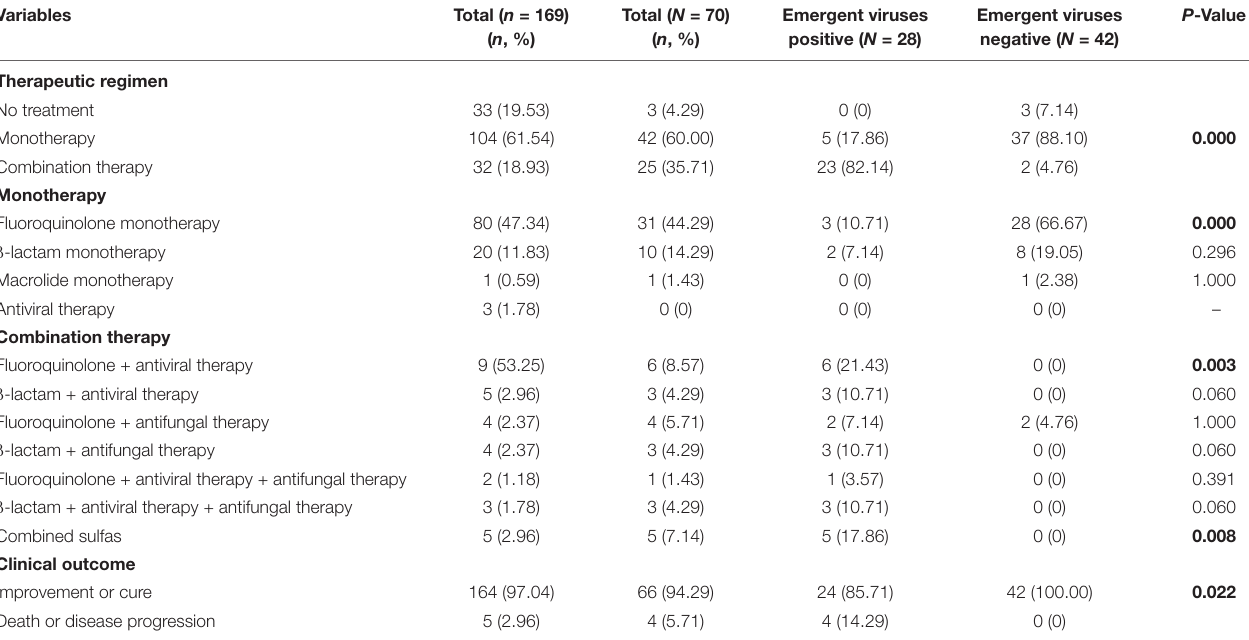
TABLE 5 | The antimicrobial treatment strategies and clinical outcome of SARS-CoV-2-Negative community acquired pneumonia patients. Variables Total ( n = 169) ( n ,